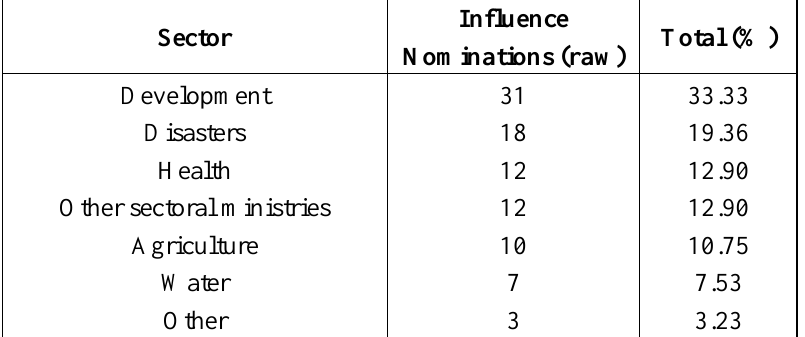
Table 7. Influence nominations for health and climate change organisations: